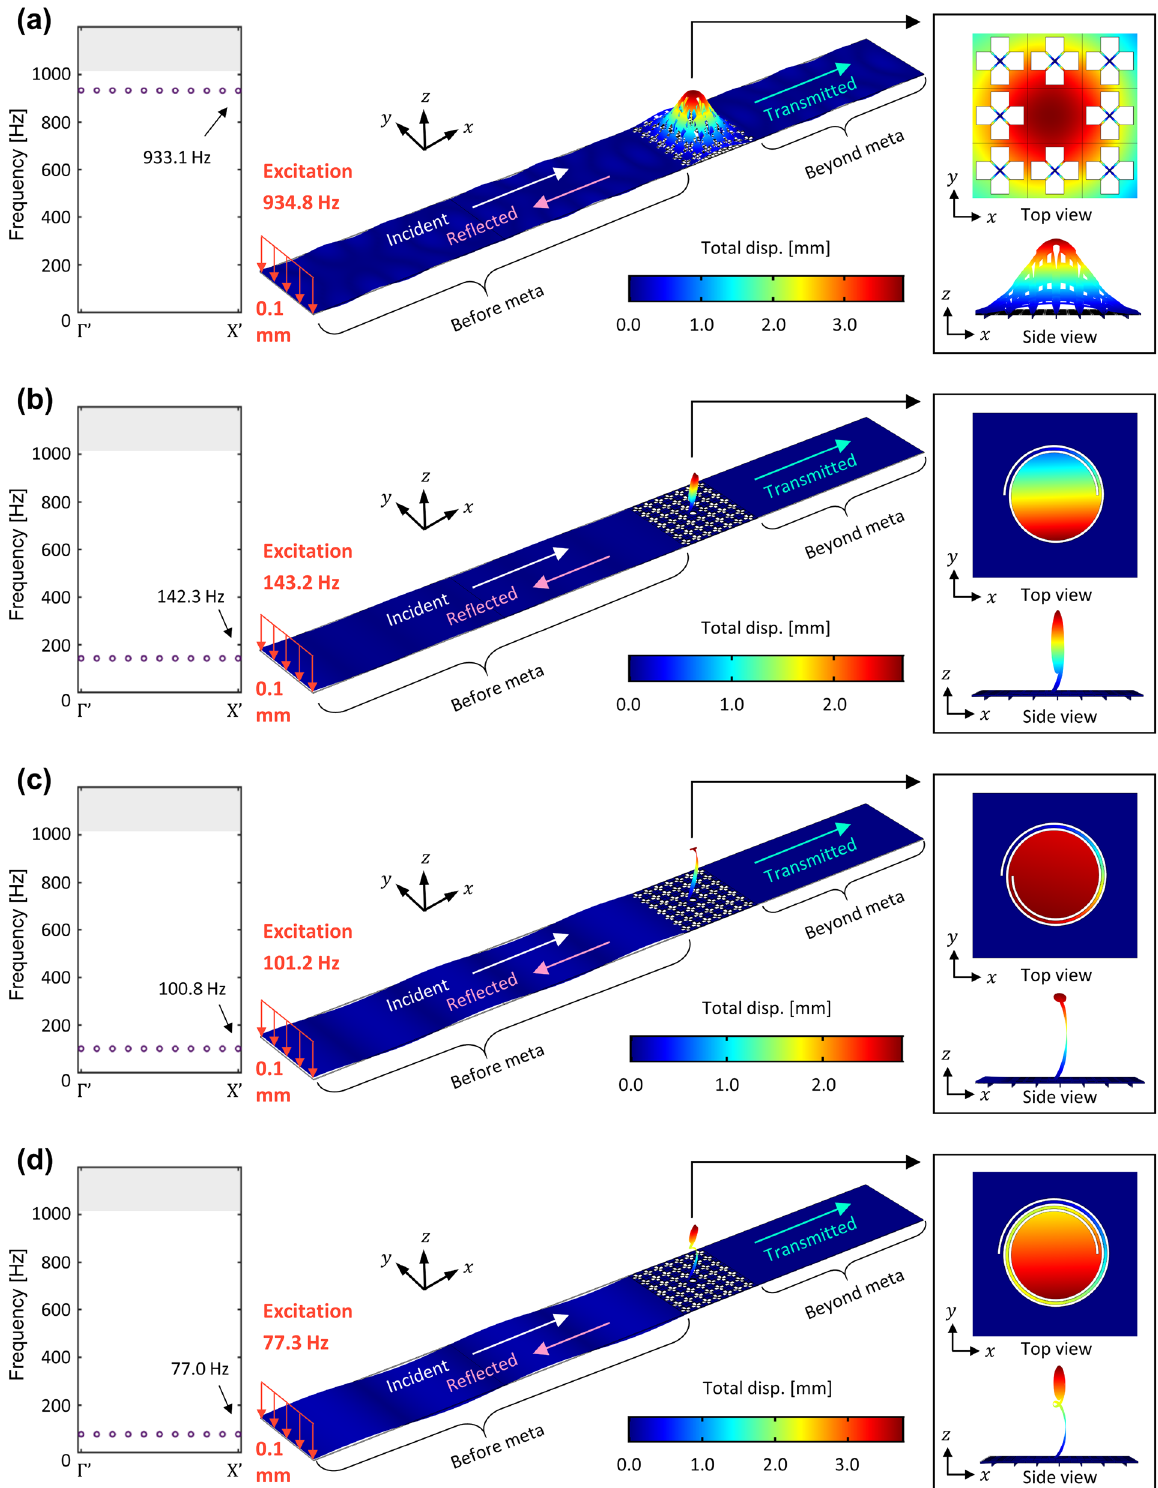
Figure 10. Simulation results. ( a ) Normal defect and ( b , c , d ) path of spiral cavity: 1 π , 2 π , and 3 π